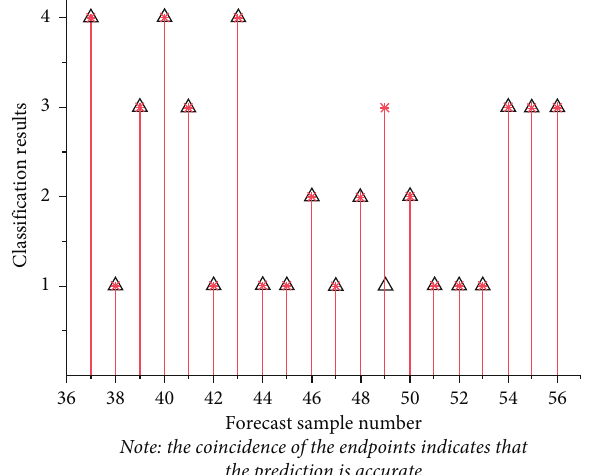
Figure 13: The classification effect of the predicted data. Note: the coincidence of the endpoints indicates that the prediction is accurate.